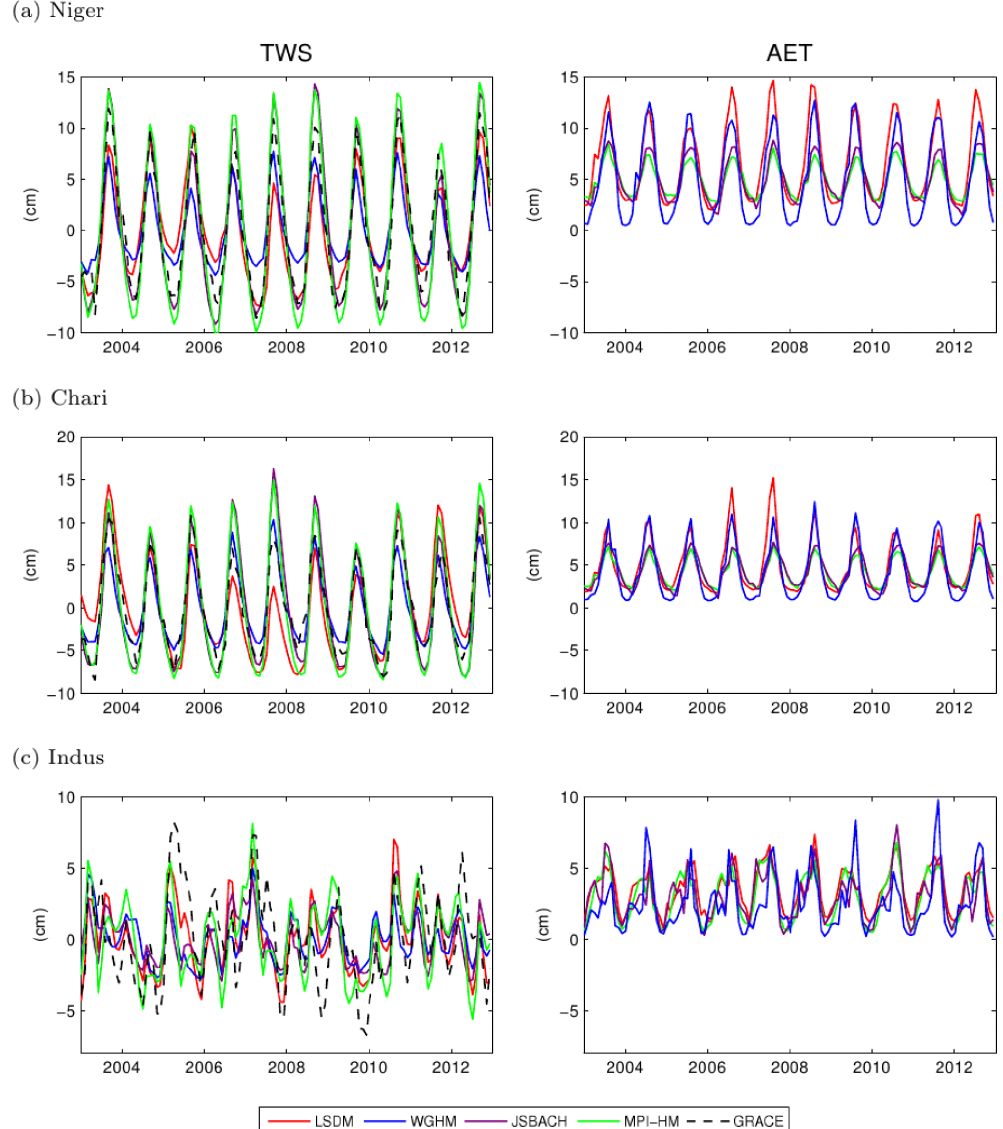
Figure 9. Time series of TWS (left) from GRACE and models and model-simulated AET time series (right), each for three different catch- ments in the dry zone: Niger, Chari, and